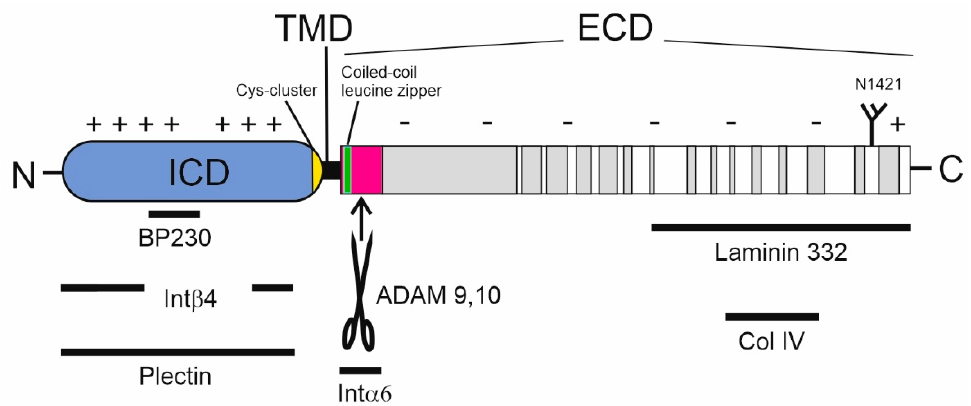
Figure 2. The primary structure of BP180 and its protein–protein interaction sites. The intracellular domain (ICD, blue) has a positive net charge and interacts with anionic regions of cytosolic/transmembrane proteins. The cytosolic cysteine cluster (yellow) of BP180 locates to the immediate vicinity of the transmembrane domain (TMD, black). The non-collagenous (NC) domain 16A (pink) contains a leucine zipper (green) and cleavage site(s) used in A disintegrin and metalloprotease (ADAM)—mediated shedding of the extracellular domain (ECM) of BP180. The other NC domains are shown in white and collagenous domains are denoted by gray shading. The charge distribution is indicated by ‘+’ and ‘ − ’. The bars show the most important protein–protein interaction sites and corresponding proteins, mapped mainly by yeast two-hybrid screens (see the main text). BP = bullous pemphigoid, Col = collagen, Int = integrin.